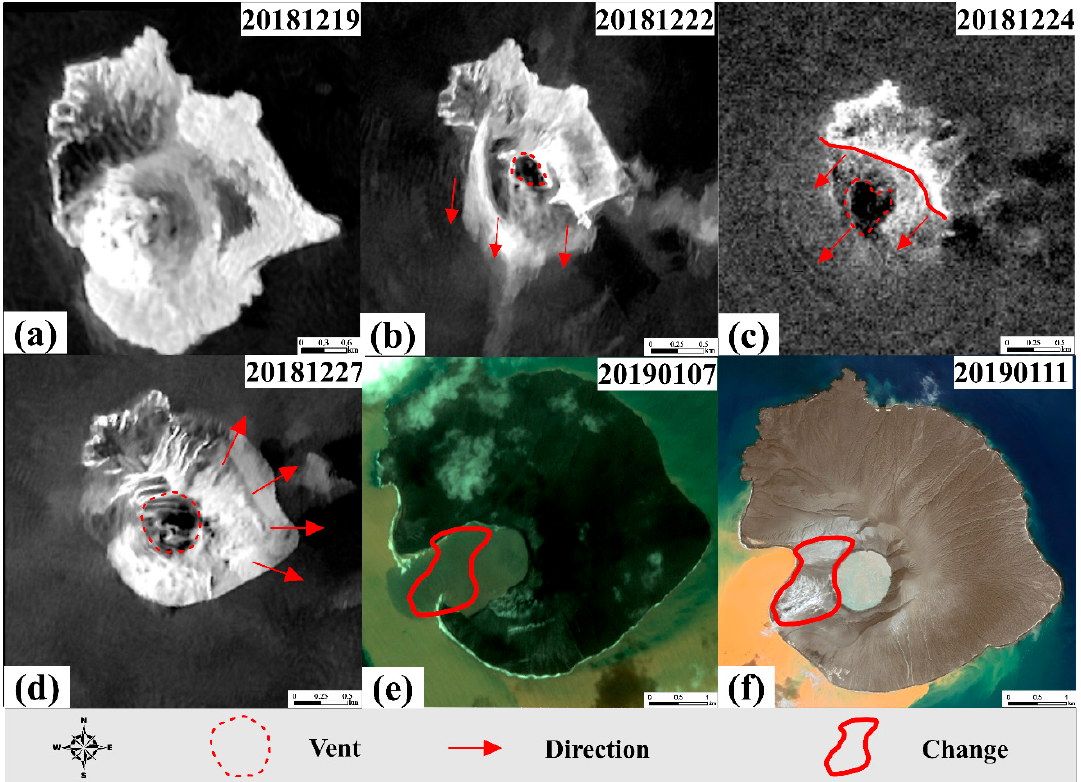
Figure 6. The volcano morphologic changes during the eruption stage analyzed by optical and SAR images. ( a ) the Sentinel-1A image on 19 December 2018; ( b ) the Sentinel-1A image on 22 December 2018; ( c ) the Alos-2 image on 24 December 2018; ( d ) the Sentinel-1A image on 27 December 2018; ( e ) the Planet image on 7 January 2019; ( f ) the Google image on 11 January 2019.